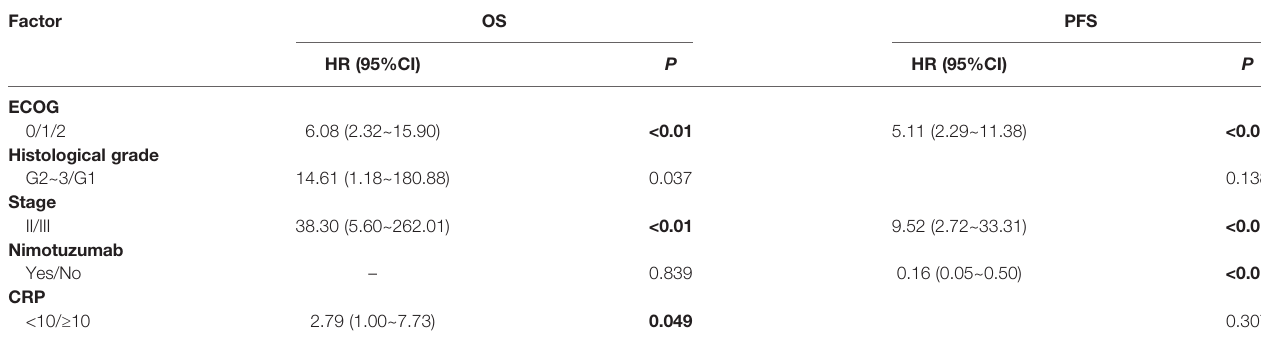
TABLE 5 | Multivariate analyses of clinical parameters of OS and PFS in overall